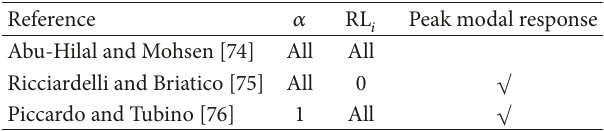
Table 2: Limits of validity and availability of closed-form peak modal response from different